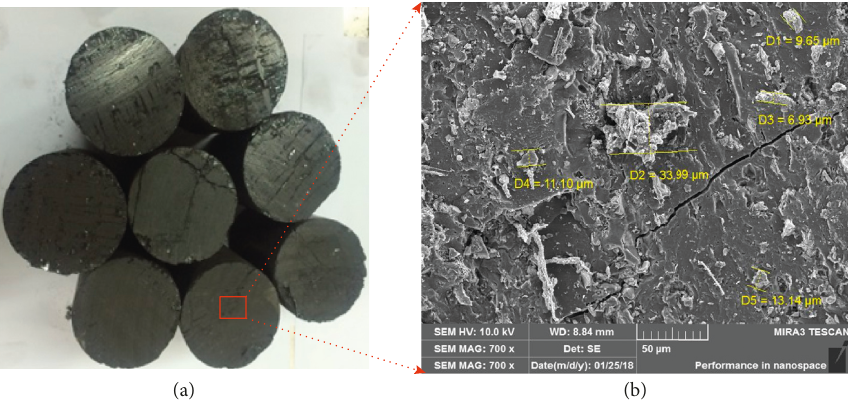
Figure 2: Standard raw coal samples and SEM of